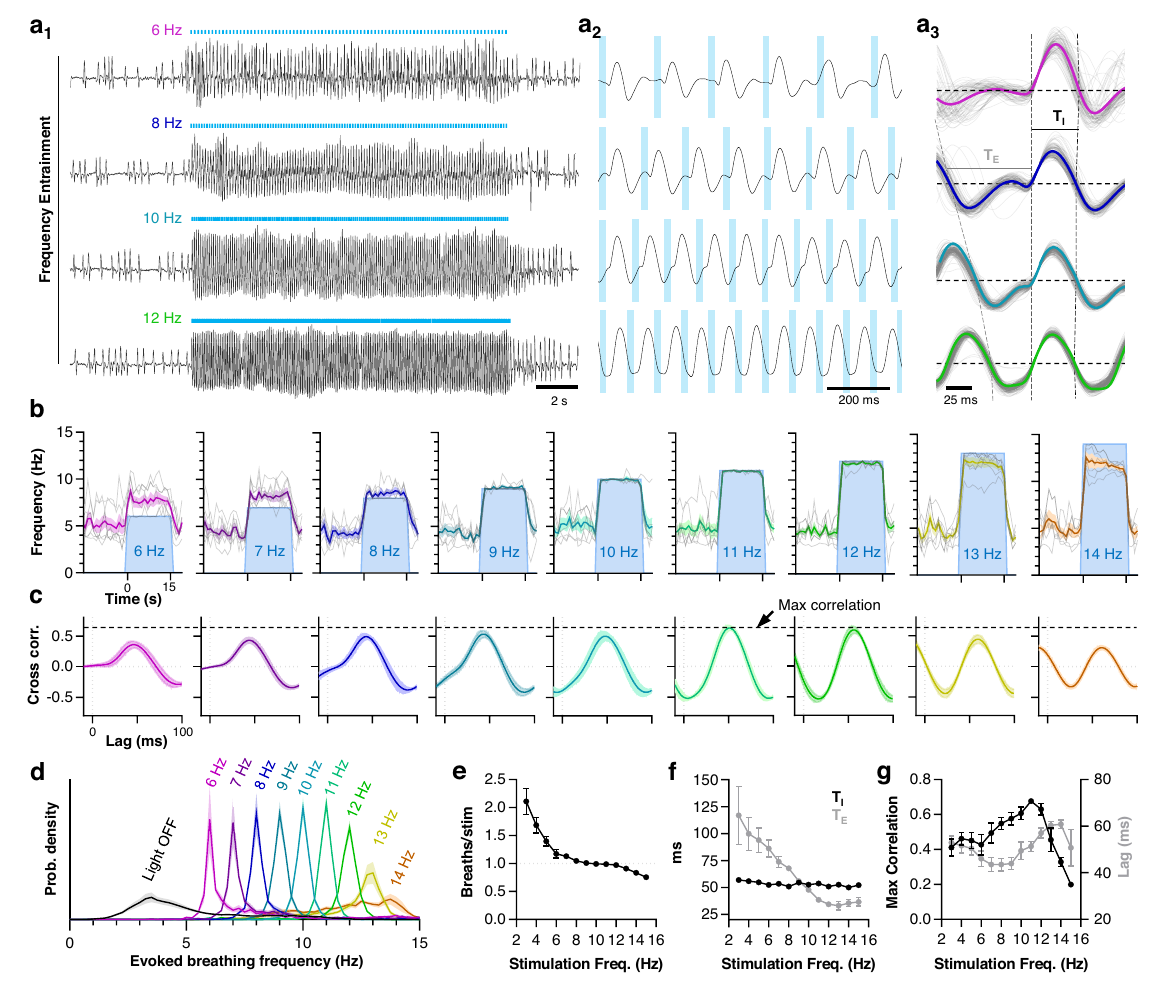
d Probability density histograms of evoked breath frequencies during 6 – 14Hz photostimulations relative to the light OFF condition (data pooled from all sti- mulation frequencies). e Average number of breaths per stimulation for each mouse ( n =7) relative to the stimulation frequency showing a near 1:1 relationship at 8 – 12Hz. f Comparison of T I and T E of the evoked respiratory rhythm, and g comparisonofmaximumcrosscorrelationandcorrespondinglagtimerelativeto stimulation frequency ( n =7). Means±SE. Source data and statistical details pro- vided in Source Data fi